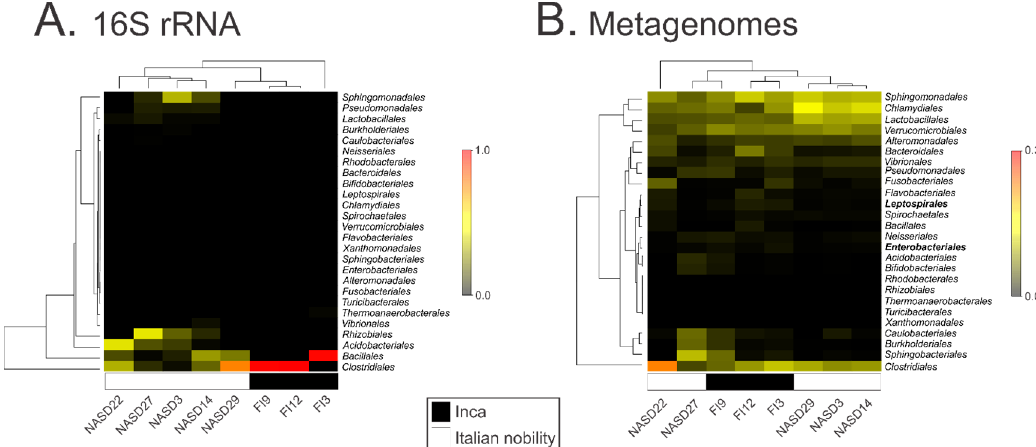
Figure 1. Characterization of the gut microbiome of the pre-Inca/Inca and Italian nobility mummies. ( A ) Heatmap of the Euclidean distances of the relative abundances of the 16S ribosomal RNA (rRNA) gene and ( B ) shotgun metagenomics sequencing data. 16S rRNA gene data were annotated using Quantitative Insights Into Microbial Ecology (QIIME) with a minimum identity cutoff of 97%.